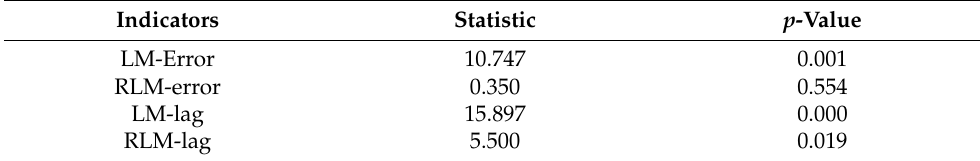
Table 4. LM Test for spatial econometric model.